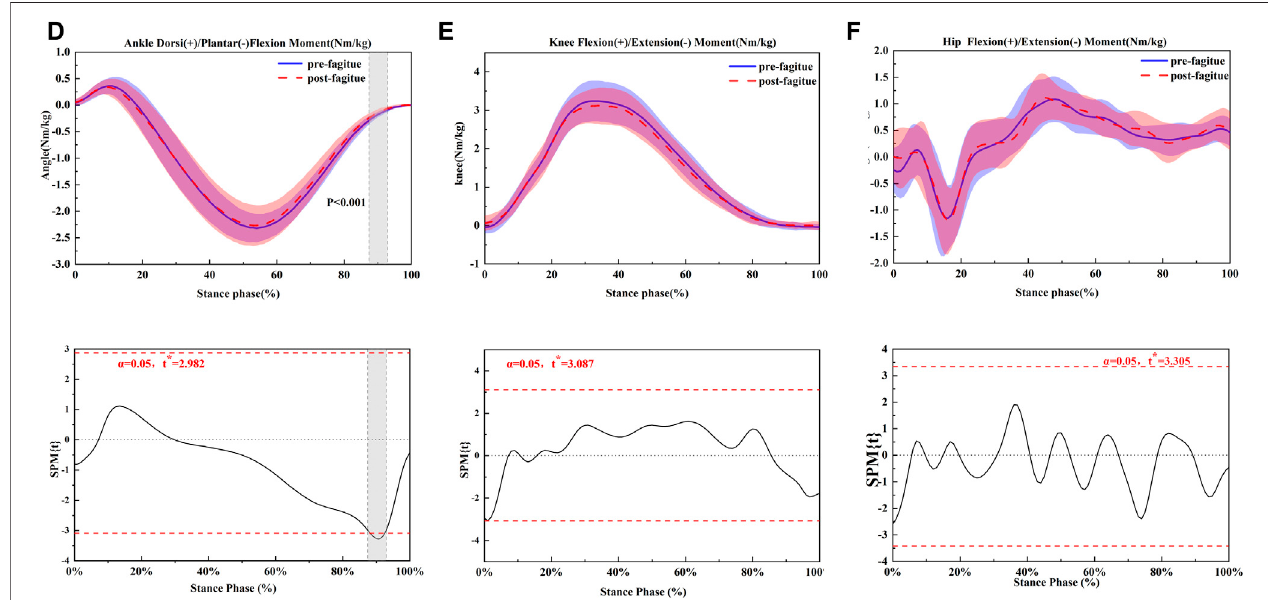
FIGURE 2 | Comparing the mean values of ankle, knee and hip joint moment from all participants between fatigue conditions (pre-fatigue; post-fatigue). * p ≤ 0.05.